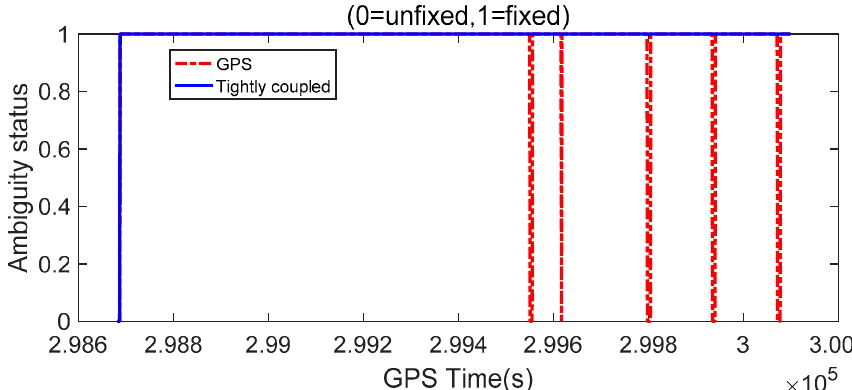
Figure 6. The ambiguity status of global positioning system (GPS) and the tightly coupled system.